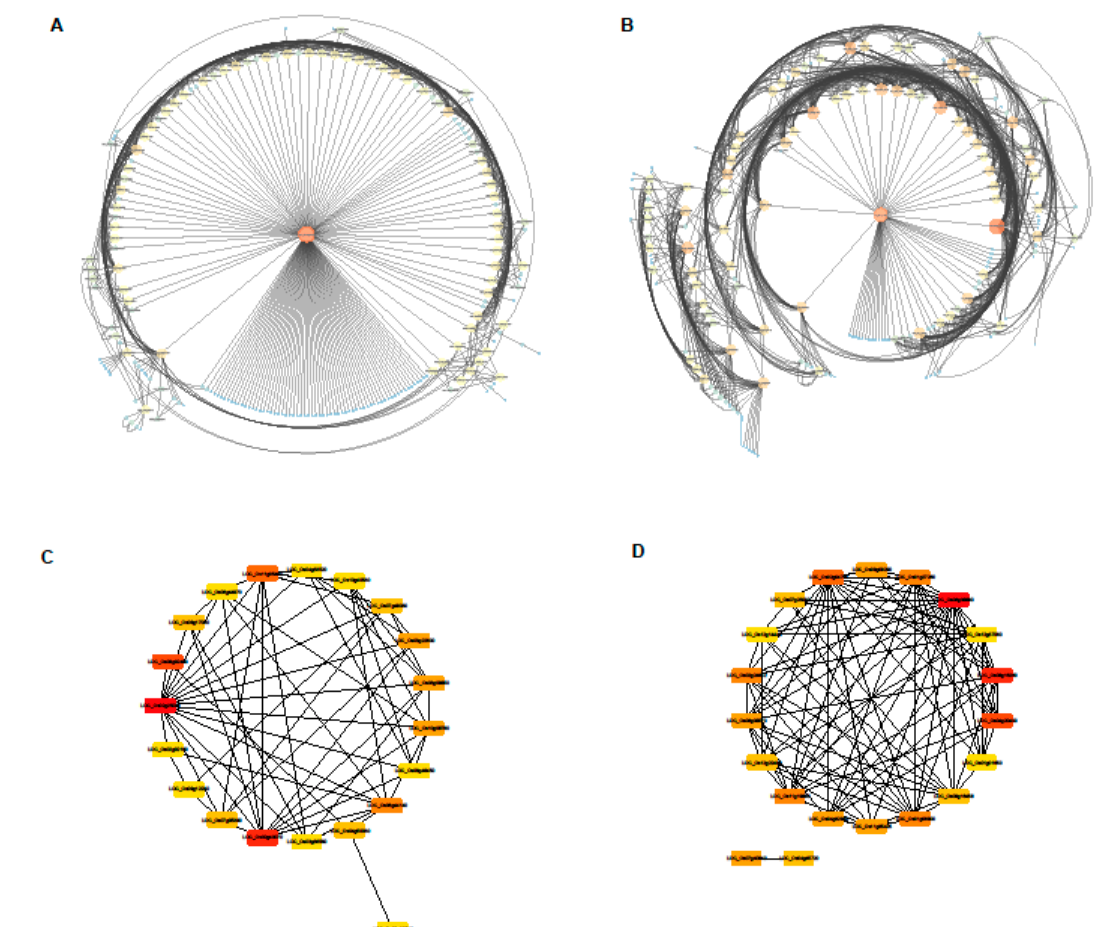
Figure 8. Co-expression network analysis of length and surface area related modules. ( A , B ) Gene co-expression networks of positive correlation magenta module ( A ) and negative correlation royal blue module ( B ) visualized using Cytoscape software platform. The size of the circle and the depth of the color indicate the degree of connectivity of the gene; ( C , D ) The correlation networks of top 20 nodes in magenta module ( C ) and royal blue module ( D ). The depth of the color represents the number of associated nodes, respectively.